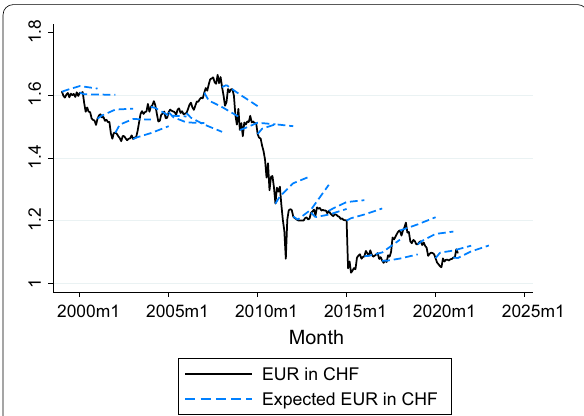
Fig. 5 Euro‑Swiss franc: Exchange Rate and Expectations. This figure shows the euro‑Swiss franc exchange rate, as well as 24‑month expectations from Consensus Economics at the end of each